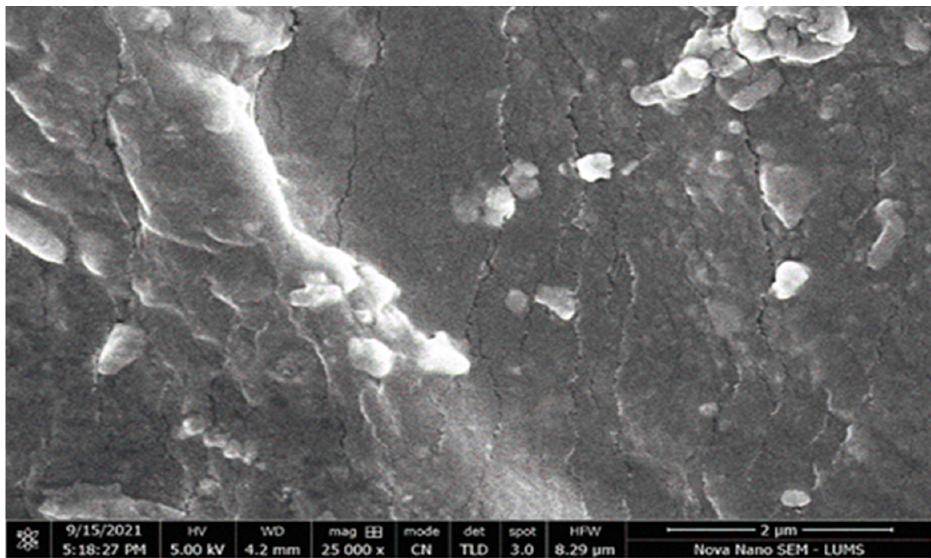
Figure 11. SEM image of β CD/AA/MBA/FAV hydrogel at 25,000 magnifications: highly porous, compact, and rough surface.